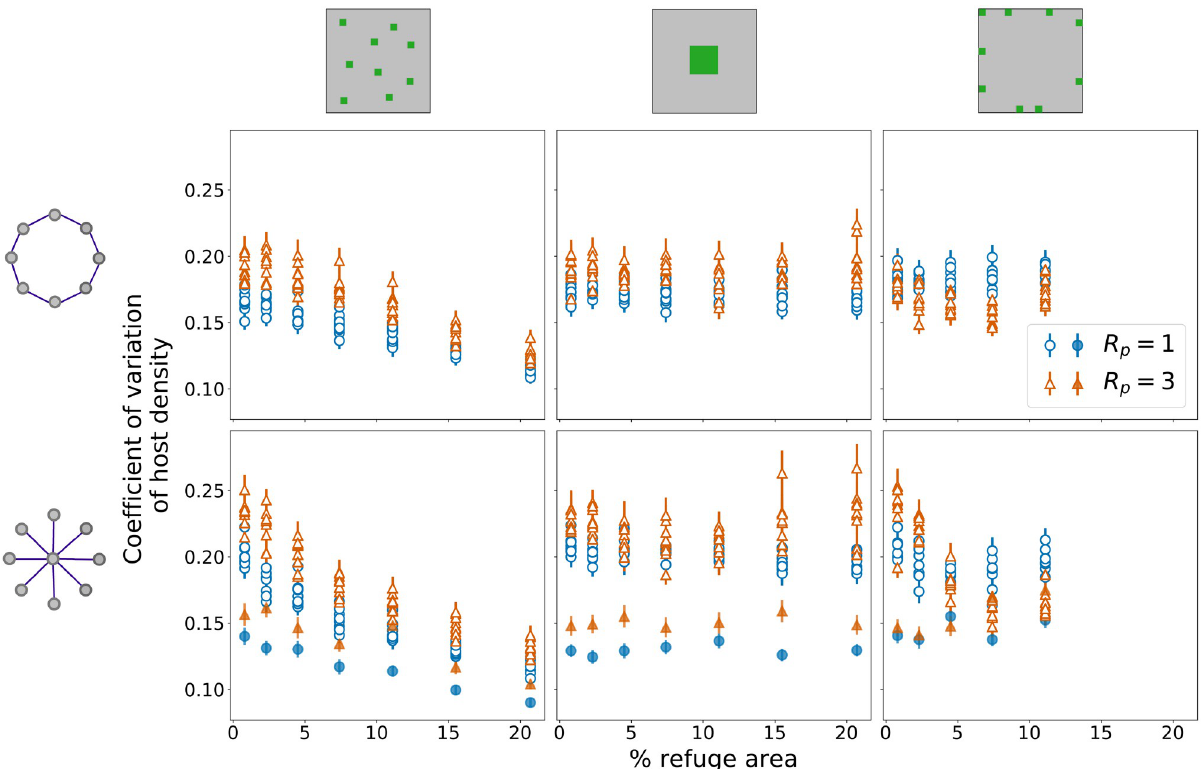
Fig 4. Coefficients of variation—Ring and star networks. Coefficients of variation (CV) for host density per crop site as a function of the percentage of refuge areas for the ring (first row) and star (second row) networks with random, block, and border distributions of refuge areas (first, second, and third columns, respectively). Ten points are shown for each percentage of refuge areas, one for each node on the external network. For the star network, peripheral nodes are represented as empty symbols and central nodes as filled symbols. Each point corresponds to the average CV for that node over 50 simulations, with error bars representing one standard error of the mean. Results are shown for two values of parasitoid dispersal radius R P = 1 (blue = 3 (orange circles) e R P